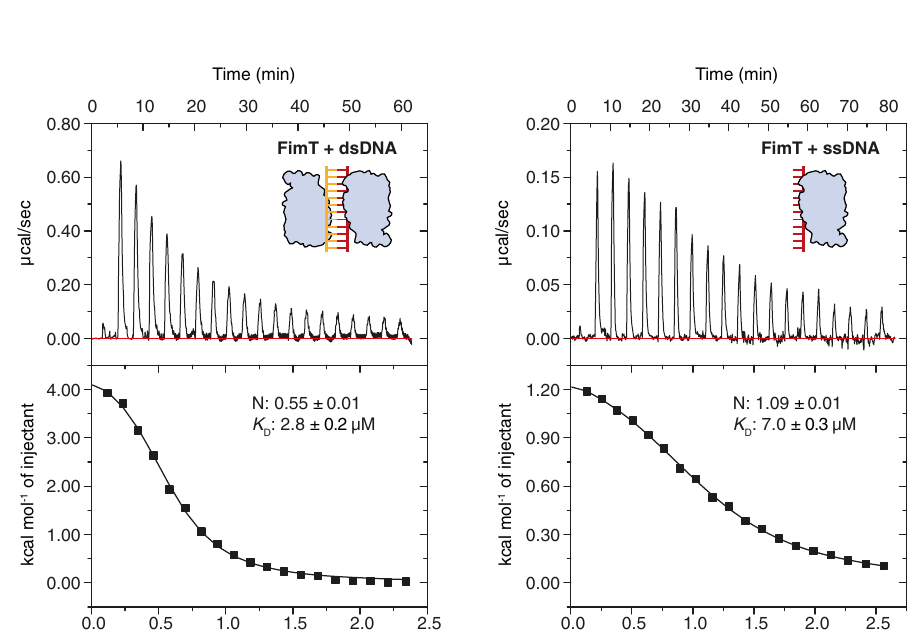
Molar ratio (DNA:FimT) Fig. 1 FimT is critical for the transformation of L. pneumophila and binds to DNA. a Natural transformation ef fi ciencies of the parental L. pneumophila Lp02 strain and Lp02 strains harbouring deletions of genes known to play a role in transformation compared to the fi mU and fi mT deletion strains. The Δ fi mT strain was complemented by ectopic expression of wild-type FimT, under the control of an IPTG-inducible promoter. The mean transformation ef fi ciencies of three independent biological replicates is shown (error bars represent standard deviation [SD]). < d.l., below detection limit (d.l.) (average d.l. = 2.0 × 10 − 8 ± 8.2 × 10 − 9 ). Statistical signi fi cances of transformation differences were determined on log-transformed 83 data using an unpaired two- sided t-test with Welch ’ s correction. All strains were compared to the parental strain. n.s., not statistically signi fi cant, p > 0.05 ( p Δ fi mU = 0.39; p Δ fi mT Ptac- fi mT = 0.89). b In vitro DNA binding of puri fi ed L. pneumophila PilA1, PilA2, FimU and FimT assessed by an EMSA. A 30 bp dsDNA fragment (1 µ M) was incubated with increasing concentrations of puri fi ed pilins (0 – 100 µ M) and resolved by agarose gel electrophoresis. This experiment was independently performed three times with reproducible results. c ITC binding studies of wild-type FimT binding to 12meric dsDNA (left) and ssDNA (right). In both cases, DNA (syringe) was injected into FimT (cell). Data were fi tted using the “ one set ” of sites model, assuming that both binding sites on the dsDNA are of equal af fi nity. Source data are provided as a Source Data fi